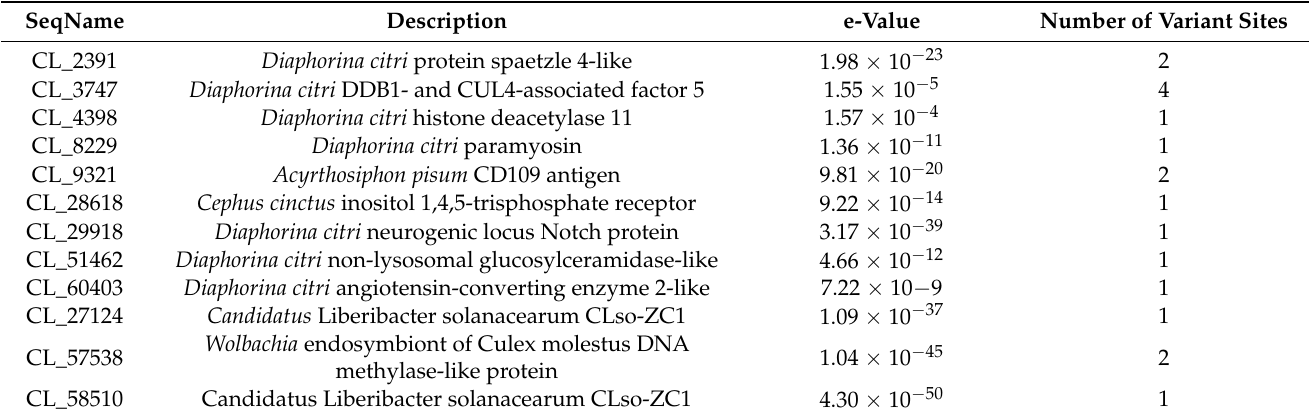
Figure 1. SNPs and p -values from association test with insecticide resistance. The SNP index on y-axis is sorted by locus names and where they are located. Highlighted loci that host strongly segregated SNPs and their annotation are also presented in Table 2. Orange dashed line indicates the p -value cutoff (1 × 10 − 14 ) for association test. Table 2. A subset of loci that host strongly segregated SNPs between insecticide susceptible and resistant psyllid